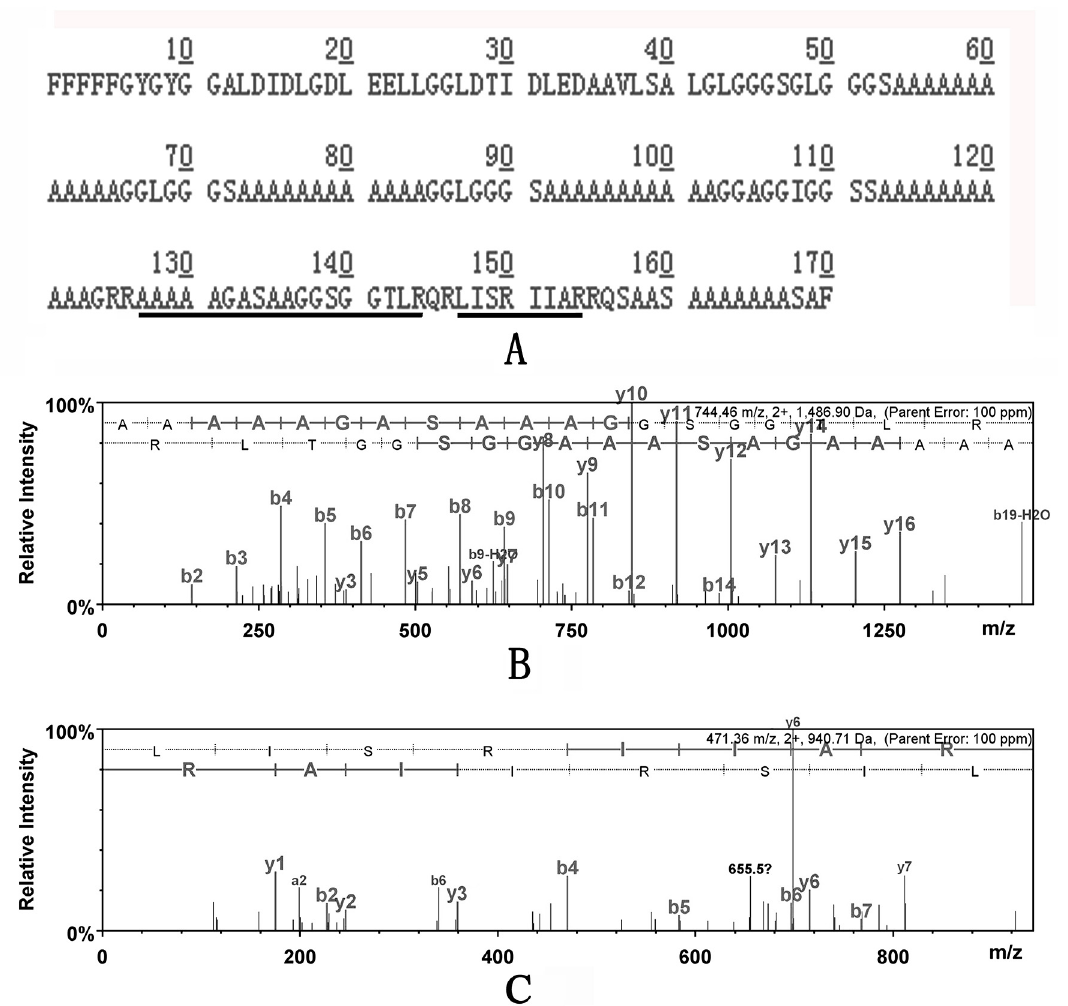
Fig 3. A representative MS/MS spectrum for the two peptides matching with EST gi|58308563, an AGL-rich protein of M . galloprovincialis . A: protein sequence derived from EST gi|58308563. The matched peptides from MS/MS spectra were underlined; B: MS/MS spectrum of the peptide “